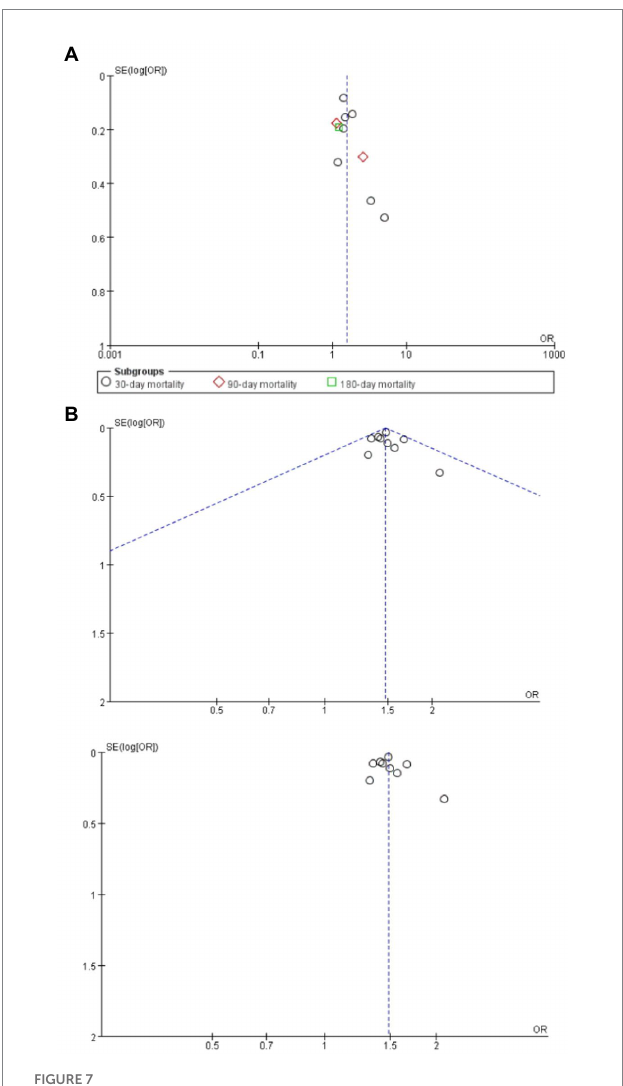
FIGURE 7 (A) Funnel plots assessing for report bias of frailty on mortality in brain tumor patients; (B) Funnel plots assessing for report bias of frailty on complications in brain tumor